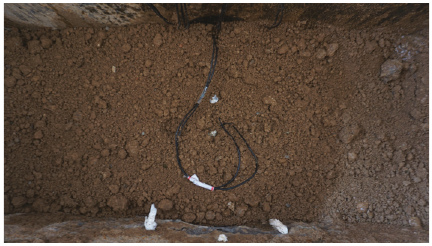
Figure 5: Imbedded grouting rock pressure sensors.